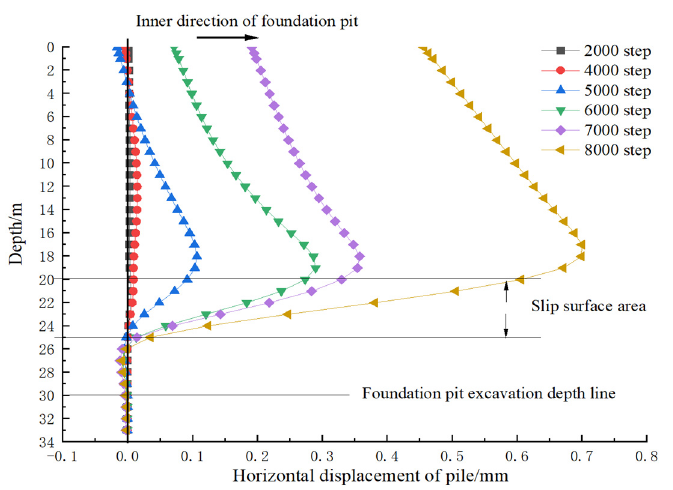
Figure 6. Displacement curve of cantilever piles with different pile diameters at 1.5 times pile spac- ing (three piles).